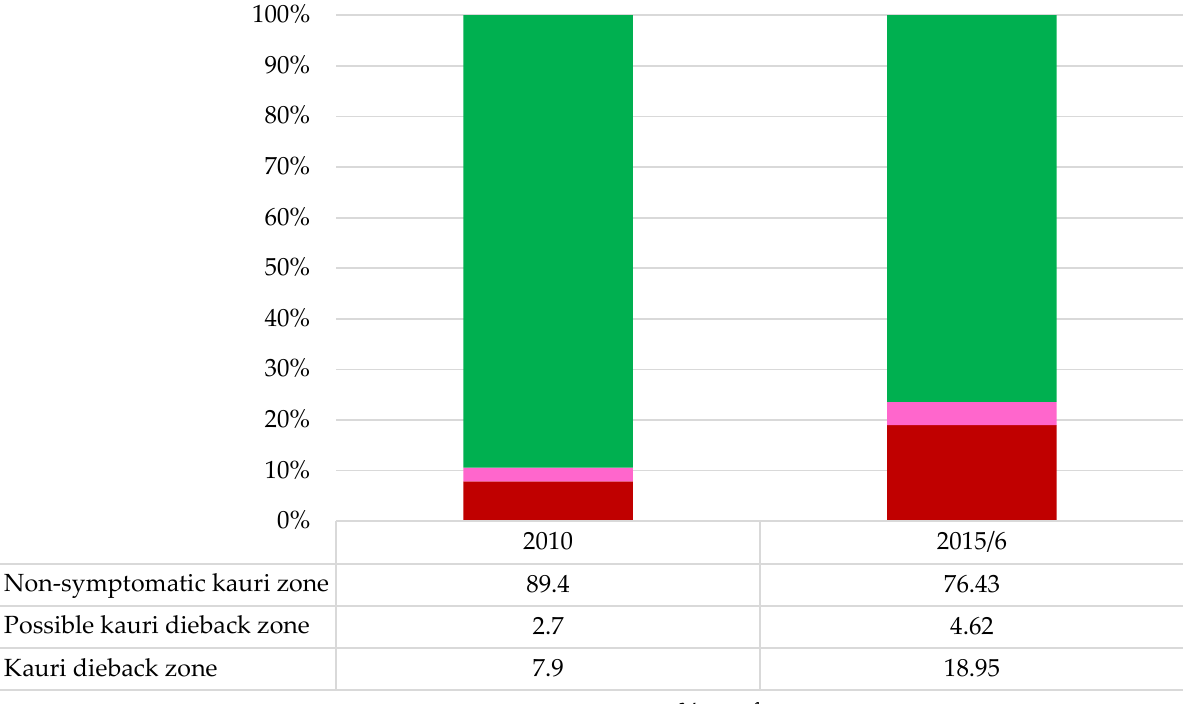
Figure 2. Change in percentage of kauri area affected by kauri dieback within the Waitākere Ranges Regional Park (WRRP) between 2010 and 2015/16.